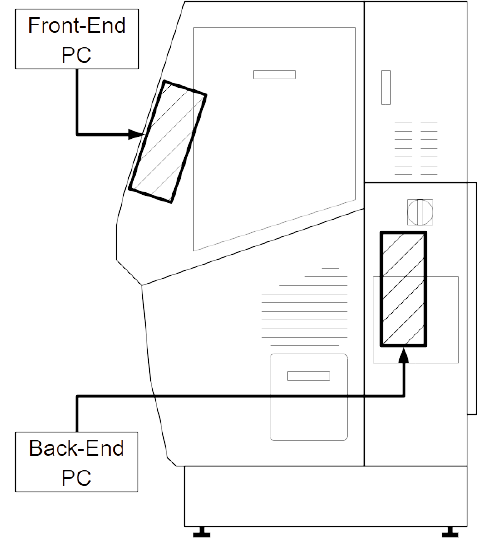
Figure 4. EMCO Concept T155 right side